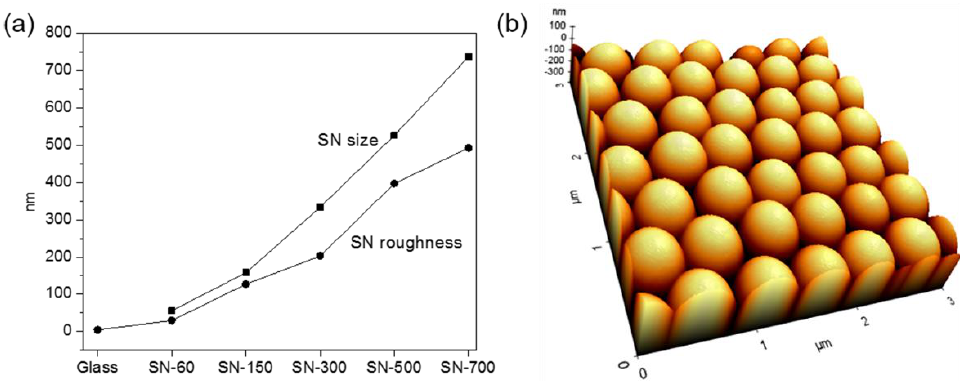
Figure 1. ( a ) Sizes of silica nanoparticles and roughness of silica nanostructured substrates (SN); ( b ) atomic force microscopy (AFM) image of SN-500.